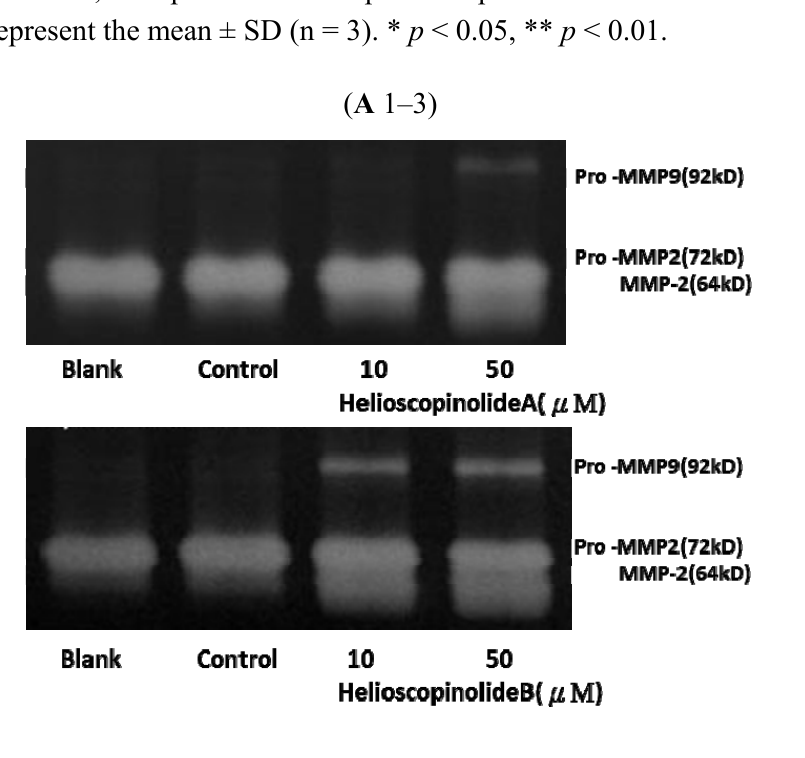
Figure 4. Effects of 3 – 5 on MMP-2, -9 activities. (A1-3) Results of gelatin zymography. Lane 1: blank; Lane 2: control; Lane 3-4: different concentration of compounds 3 – 5